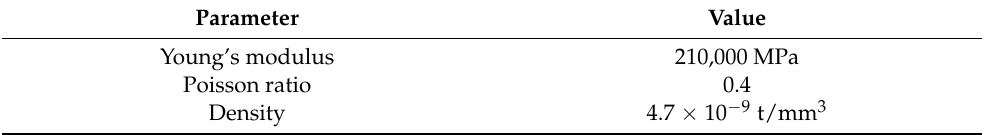
Table 1. Material data of [20] chosen as the default for the simulation framework.